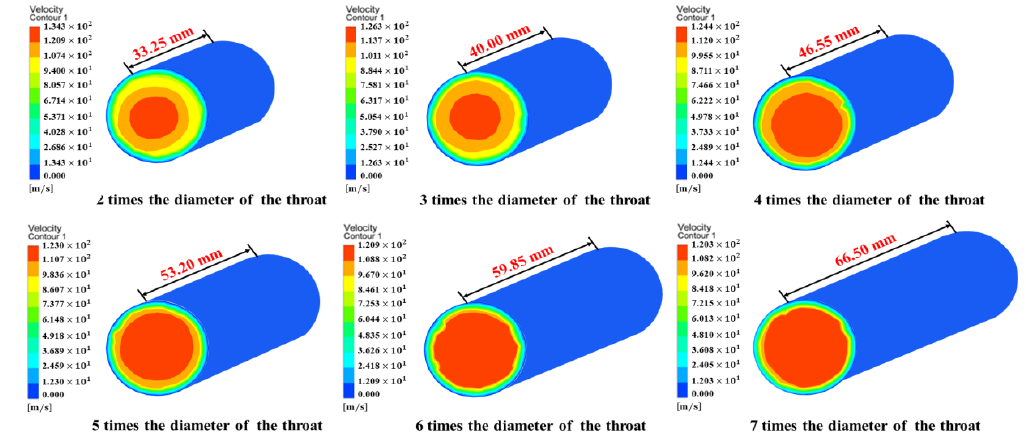
Figure 8. Velocity cloud diagrams of the throat outlet with different ratios of the length of the throat to its diameter. Table 7. Effect of the different angles of the diffuser tube on pump efficiency.